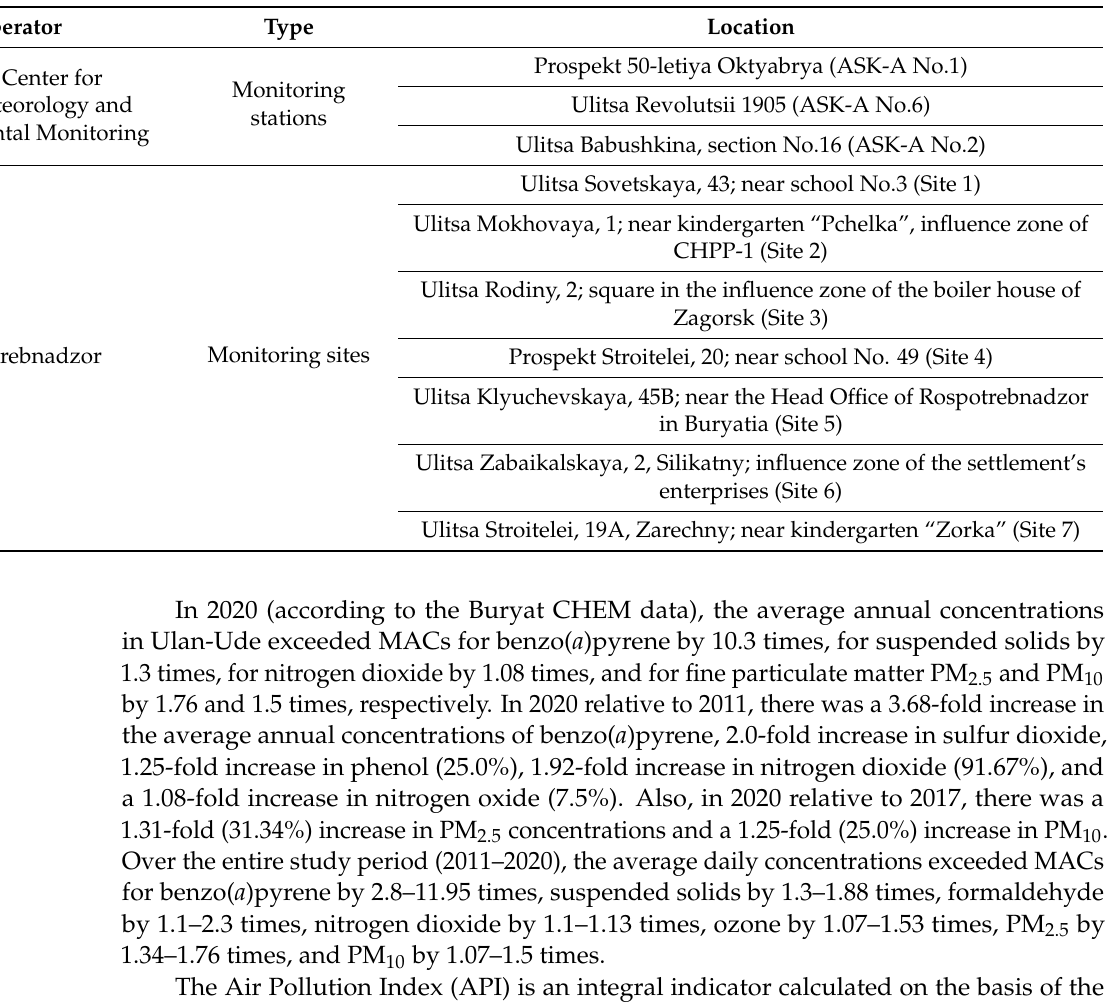
Table 1. Locations of the air monitoring stations/sites in